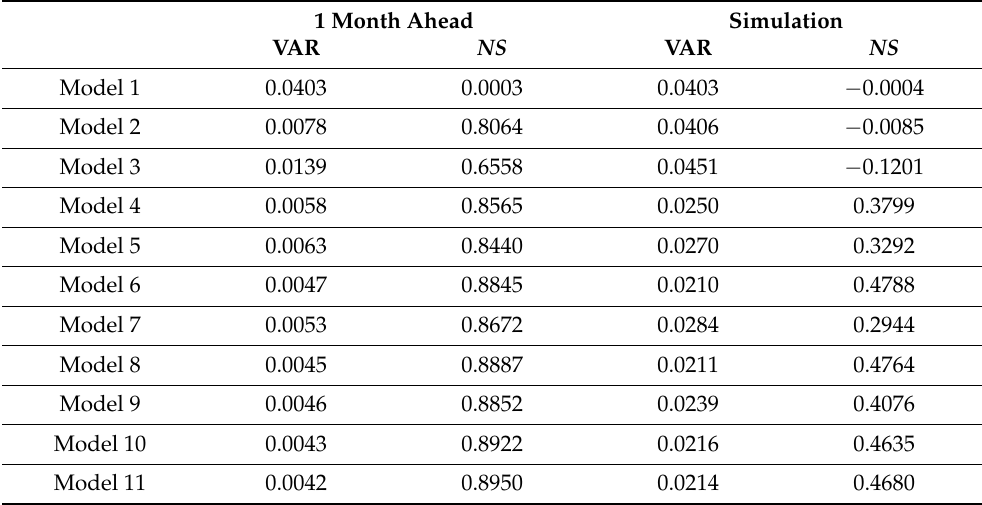
Table 2. VAR and NS values estimated for the training set of data, for the one month ahead prediction and simulation.